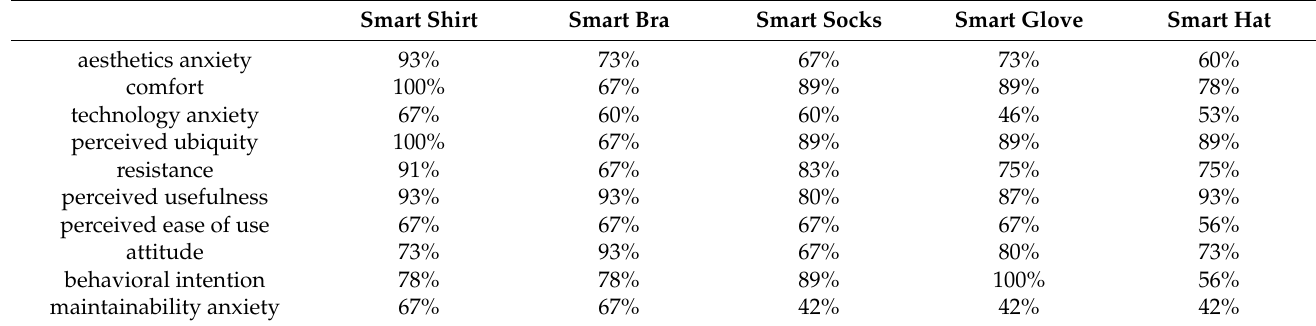
Table 2. Table of results of the comparison between smart